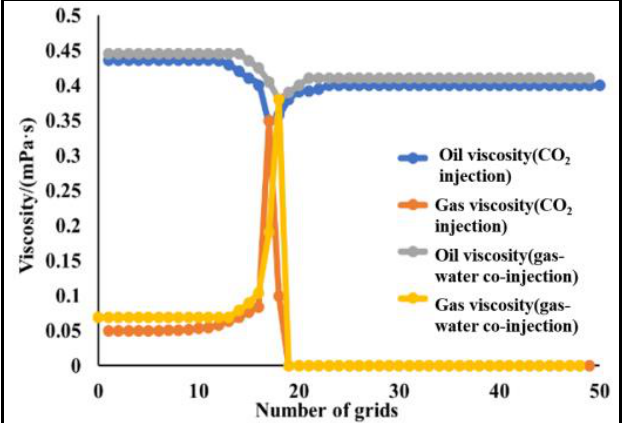
Figure 21. Variation of oil and gas viscosity.